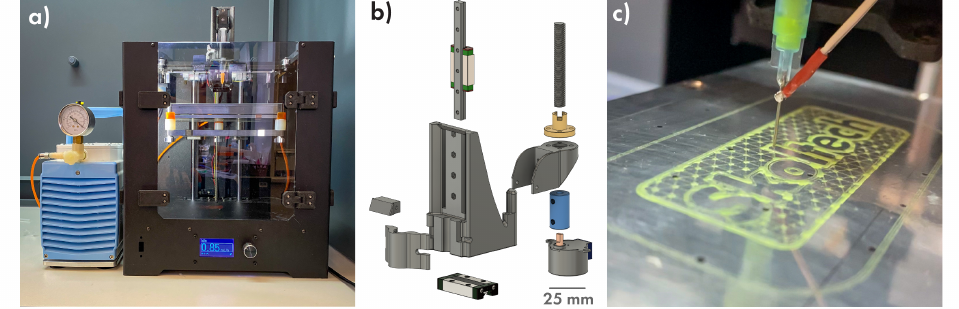
Figure 3. ( a ) Commercial 3D printer upgraded to use for drug gel printing, syringe extruder 3D model ( b ) and a complex shape print example ( c